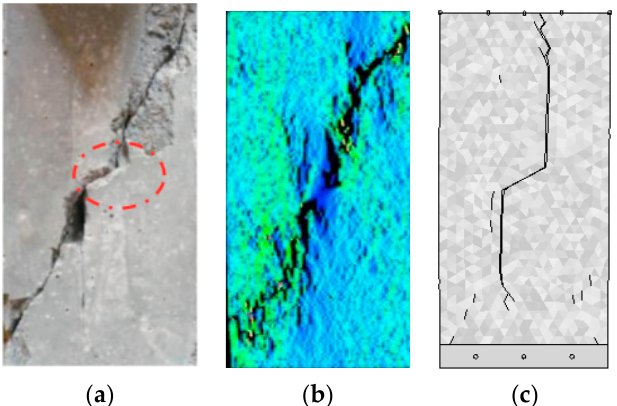
Figure 5. Crack propagation comparison between laboratory test and numerical simulations with ( a ) laboratory test, ( b ) rock failure process analysis (RFPA) numerical simulation, and ( c ) DDARF numerical simulation.